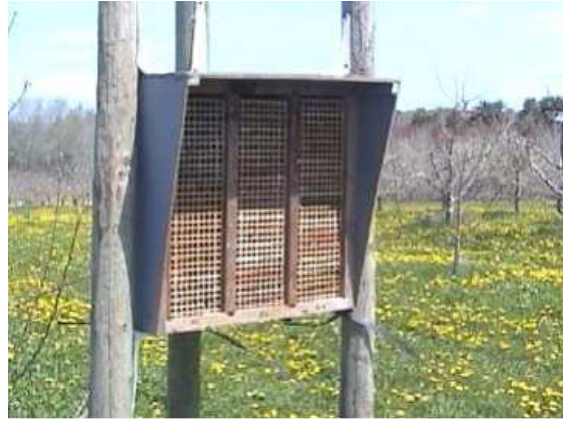
F IGURE 1. Wooden nests used for Osmia lignaria . These were placed in the south end of the orchard in an attempt to create a gradient of